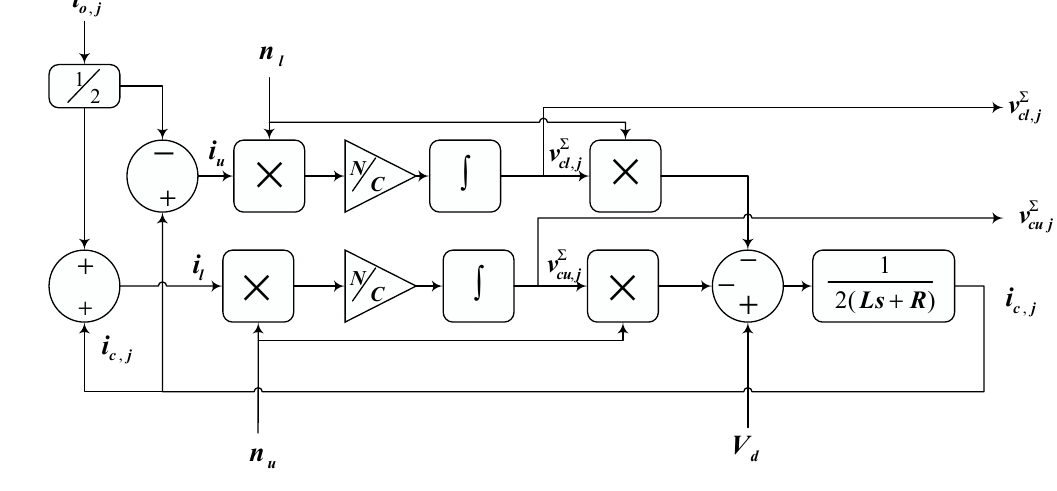
Figure 3. Leg level model of MMC.